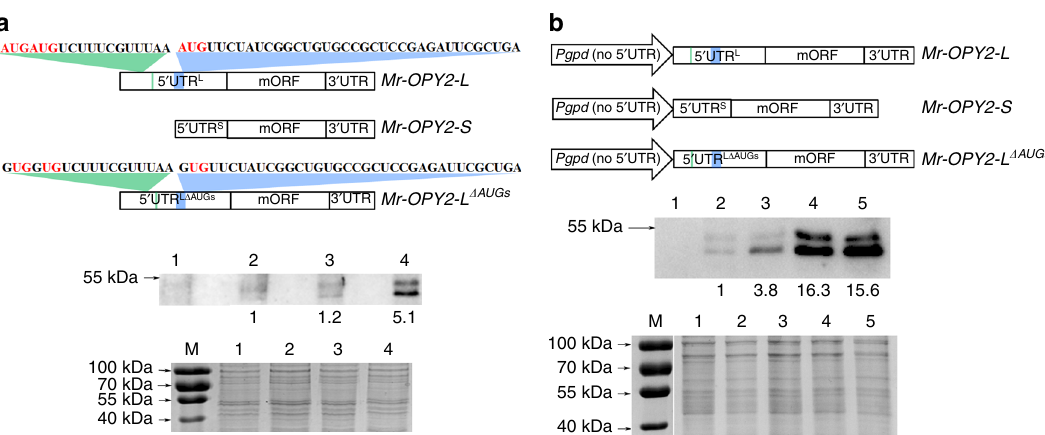
Fig. 3 The uORFs suppress translation ef fi ciency of the major ORF in Mr-OPY2-L . a Top panel: graphic representation of WT transcripts Mr-OPY2-L, Mr- OPY2-S and the mutated Mr-OPY2-L ( Mr-OPY2-L Δ AUGs ) that has GUGs in place of AUGs (highlighted in red). The blue and green labelled sequences in the 5 ′ UTR represent the positions of the two different uORFs (these color conventions are also used in the top panel in b . Middle panel: Mr-OPY2 protein levels in SDY grown cultures of: (1) Δ Mr-OPY2 ; (2) WT; (3) T-Mr-OPY2-L AUG (the native Mr-OPY2 gene was replaced by a native genomic Mr-OPY2 clone); and (4) T-Mr-OPY2 Δ AUGs (the native Mr-OPY2 gene was replaced by a genomic Mr-OPY2 clone with mutated uORFs). Bottom panel: a portion of the loading control gel (for the Western blot analysis in the middle panel) stained with Coomassie Brilliant Blue. M: Protein ladder. b The short Mr-OPY2-S transcript is more ef fi ciently translated than the longer Mr-OPY2-L . Top panel: graphic representation of the constructs containing the transcript Mr-OPY2- L , Mr-OPY2-S, and Mr-OPY2-L Δ AUGs driven by the Pgpd-NUTR . The 'No 5 ′ UTR' indicates that the 5 ′ UTR of the M. acridum gpd gene is excluded. These constructs were transformed into the Mr-OPY2 deletion mutant Δ Mr-OPY2 . Middle panel: representative Western blot image and analysis to quantify Mr- OPY2 levels in SDY grown cultures of: (1) Δ Mr-OPY2 ; (2) WT; (3) Δ Mr-OPY2 :: Mr-OPY2-L ; (4) Δ Mr-OPY2 :: Mr-OPY2-S , and (5) Δ Mr-OPY2::Mr-OPY2-L Δ AUGs . Bottom panel: a portion of the loading control gel (for the western blot analysis in the middle panel) stained with Coomassie Brilliant Blue. M: Protein ladder. For western blot analysis ( a , b middle panels), the Mr-OPY2 levels are calculated relative to the WT which is set at 1 ( Δ Mr-OPY2 is a negative control). The uncropped images of the western blots and the SDS-PAGE gels are shown in Supplementary Fig. 12. Images are representative of at